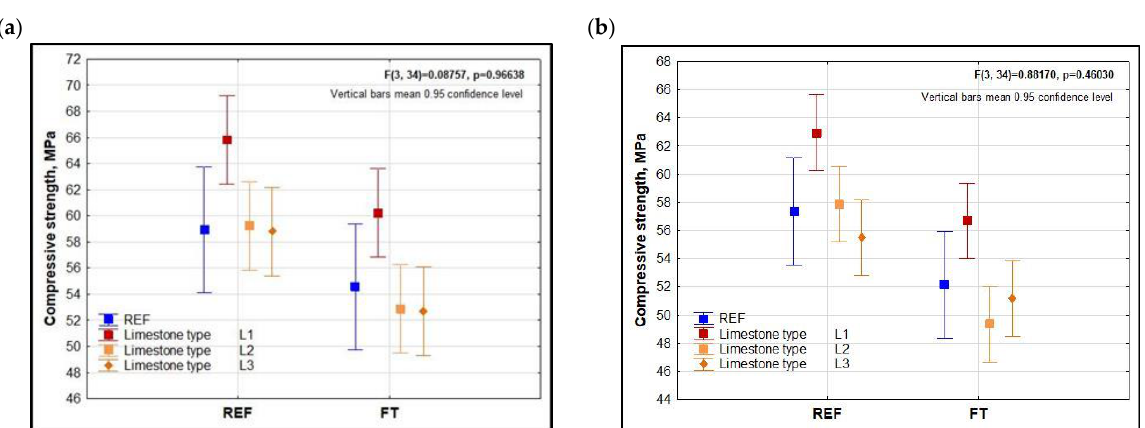
Figure 16. ANOVA analysis of the effect of limestone type on the compressive strength of reference